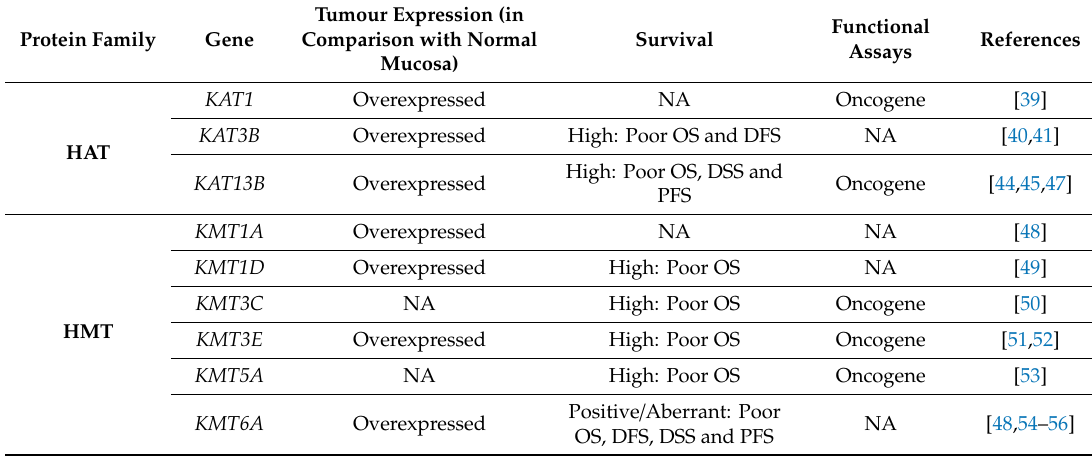
Table 1. Summary of the most relevant publications concerning the role of DNA / histone writers involved in oesophageal